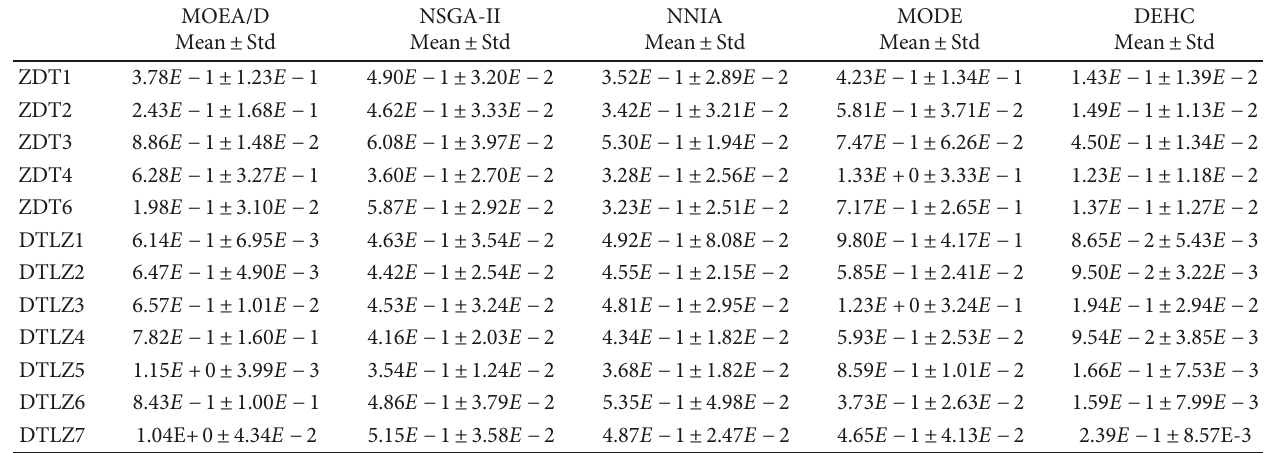
Table 2: The IS comparison results of DEHC with 4 MOEAs on 12 problems.